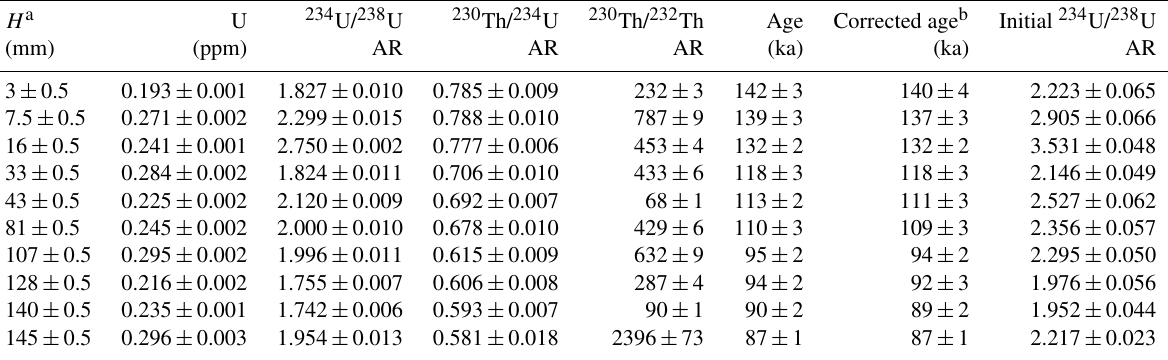
Table 1. U-series results. AR stands for activity